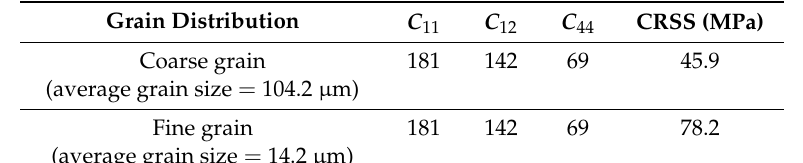
Table 3. Elastic constants and critical resolved shear stress (CRSS).